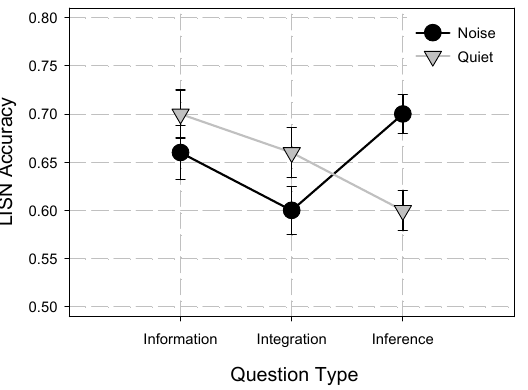
Figure 3. Mean accuracy for information, integration, and inference questions in the listening comprehension test. Error bars depict one standard error of mean. LISN = Lecture Interview and Spoken Narratives test.